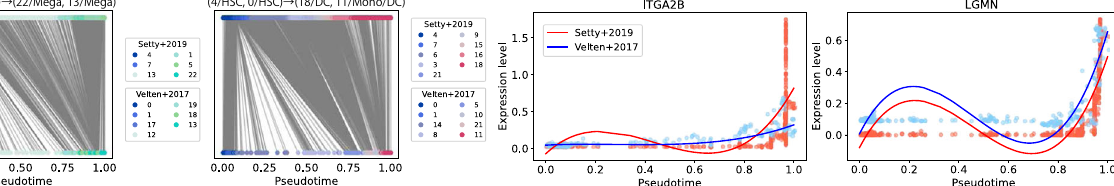
Fig. 5 | Validation of CAPITAL on different scRNA-seq datasets of human bone marrowcells. a A UMAP plot of clustering results of Settyetal.'sdata.A trajectory tree predicted by CAPITAL is shown by a thick black line, where the solid lines indicatethelineartrajectoriesthatarecomparedin( d )and( e ),whereasthedashed linesrepresenttheothers. b AUMAPplotofVeltenetal.'sdata. c Analignedtreeof the trajectories of clusters, where each pair of numbers in a node denotes the clusters shown in ( a ) and ( b ). # denotes a space, meaning that it has no aligned cluster pair. d Cell – cell matchings along the trajectory paths from root (4/HSC,